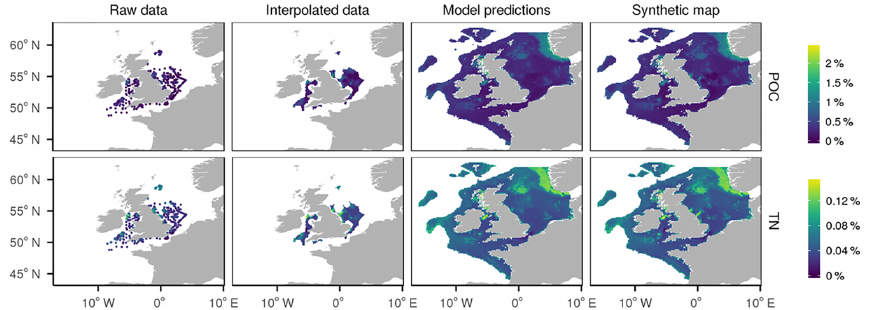
Figure 10. Derivation of the synthetic maps of particulate organic carbon (POC) and nitrogen (TN). Data were interpolated based on field observations in areas with good spatial coverage. In other regions, parameters were predicted using a random forest which had mud content and physical environmental variables as predictors.